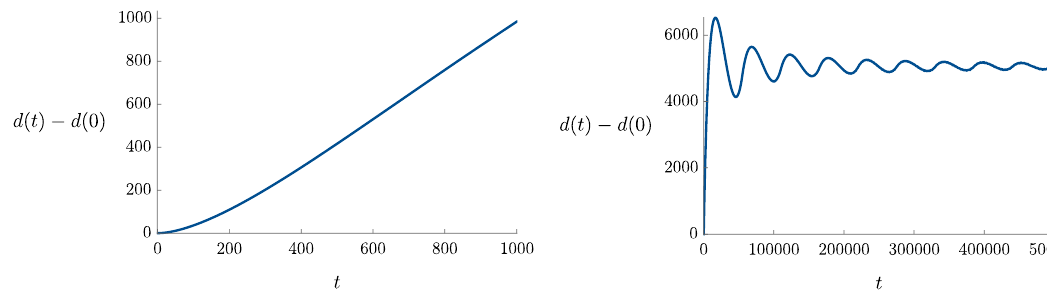
Figure 6 . Length across the Einstein-Rosen bridge (or the volume of the black hole interior), including non-perturbative corrections, obtained by using (6.4) for u 1 − u 2 = β/ 2 + i t . Left: at early time our model exhibits a linear growth of the length, as expected in all gravitational theories. Right: at later times ∼ e S 0 , approximate recurrences appear due to the clock behavior of the energy spacing, for small energy differences. For higher values of β the recurrences become more and more pronounced, and periods of linear growth and linear decay are more clearly visible. This should be contrasted with the results found in [8] for theories with a chaotic spectrum for which the noise of the plateau was much smaller and much more